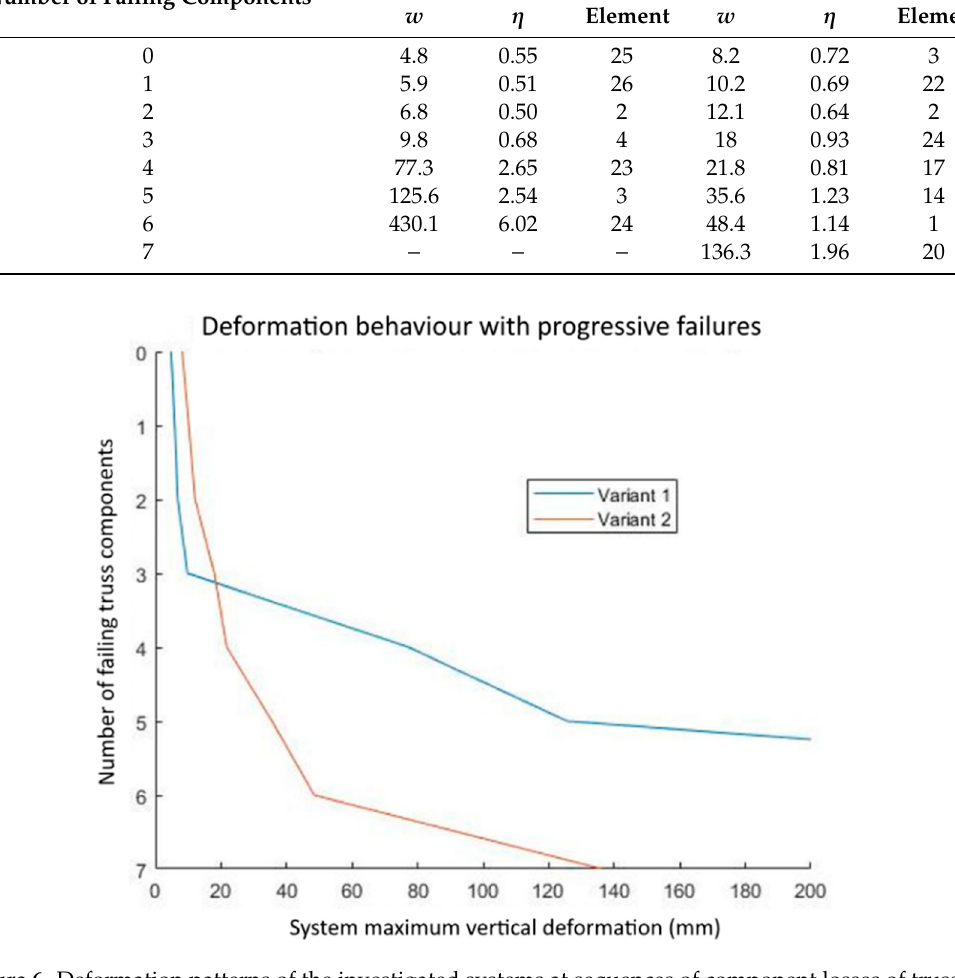
Figure 6. Deformation patterns of the investigated systems at sequences of component losses of truss system variants 1 and 2 (FEM results).